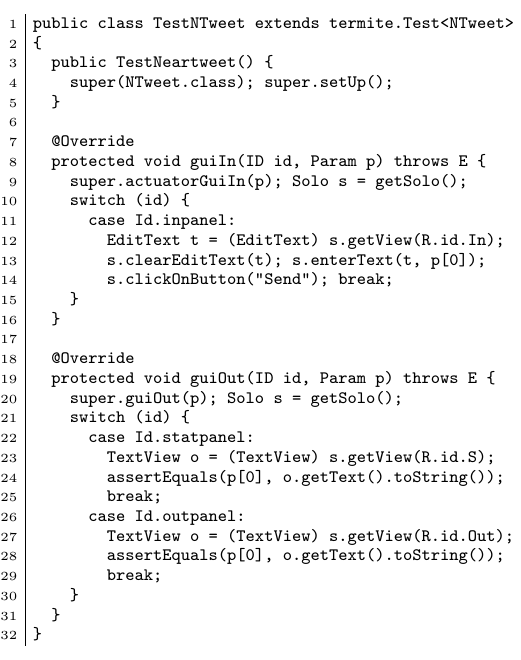
Figure 8: Java code of NearTweet tester